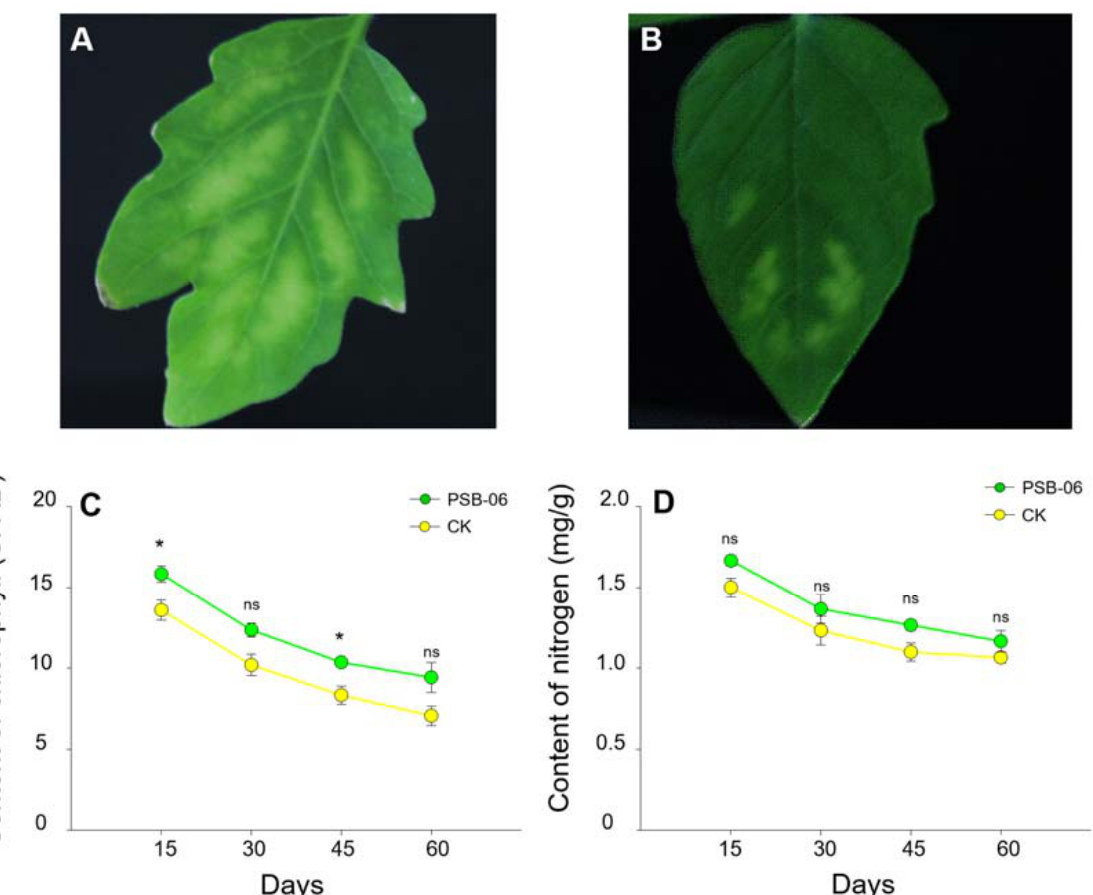
Figure 3. Effect of PSB ‐ 06 on plant photosynthesis ‐ related pathways. ToCV ‐ infected tomato plants treated with water after 45 days ( A ). ToCV ‐ infected tomato plants treated with PSB ‐ 06 after 45 days ( B ). The content of chlorophyll (SPAD) in the tomato plants ( C ). The content of nitrogen (mg/g) in the tomato plants ( D ). The X ‐ axis indicates the number (15, 30, 45, 60) of days that the tomato plants were treated. Data are the mean ± SE, and different letters on the bars indicate significant differences.